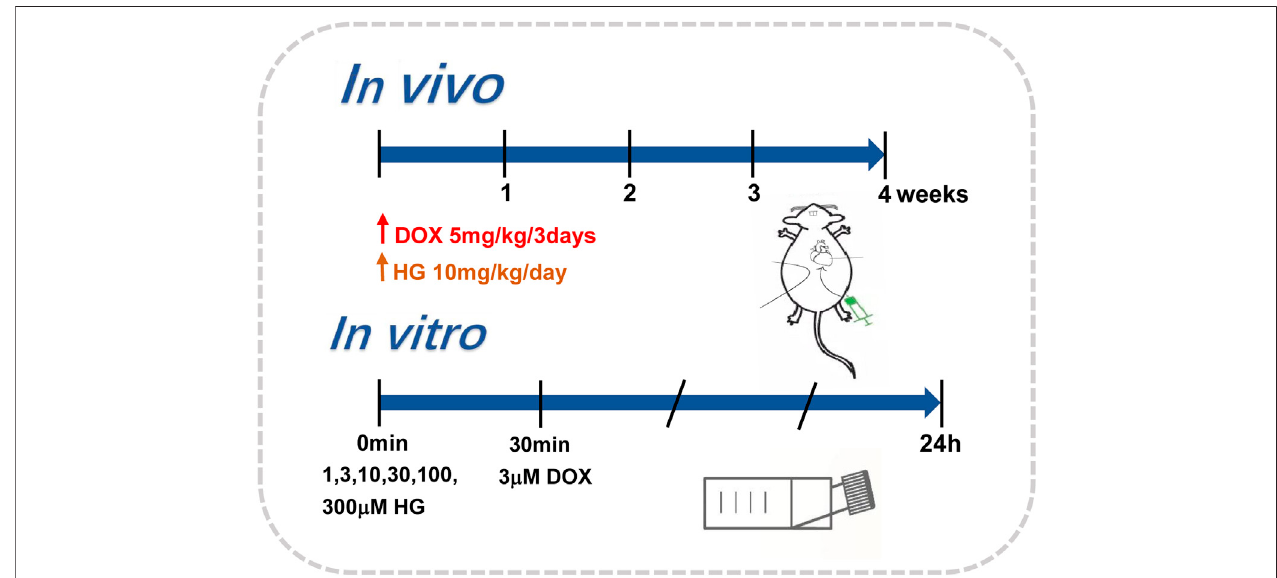
FIGURE 1 | Administration modes in vivo and in vitro